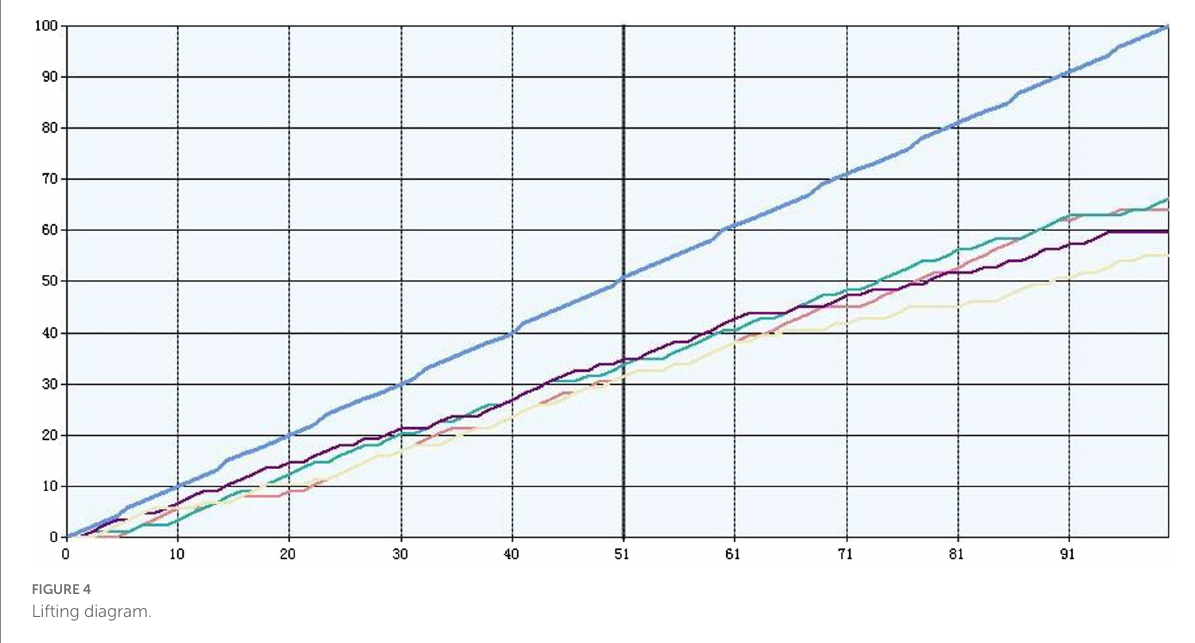
FIGURE 4 Lifting diagram.